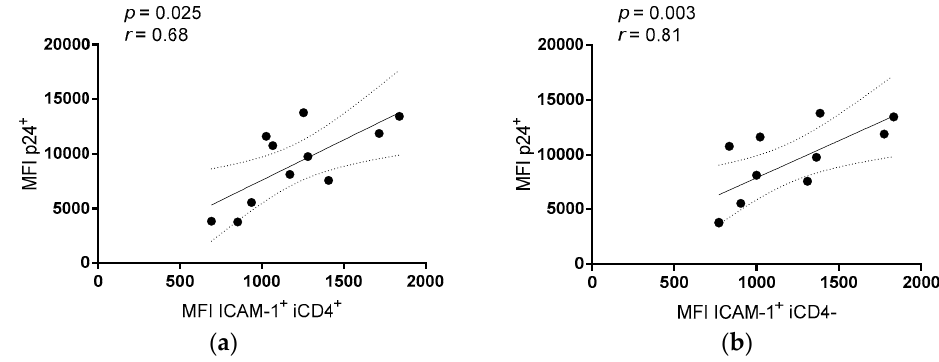
Figure 4. The per-cell expression of ICAM-1 is correlated with the MFI of p24 expression in HIV infected T cell subsets. Correlation of MFI of ICAM-1 expression with the MFI of p24 expression in ( a ) iCD4 + , and ( b ) iCD4 − HIV infected T cell subsets. Each data point represents T cells isolated from a separate individual ( n = 11). Dotted lines represent 95% confidence intervals. Significant values ( p ) and correlation coefficients ( r ) are shown.